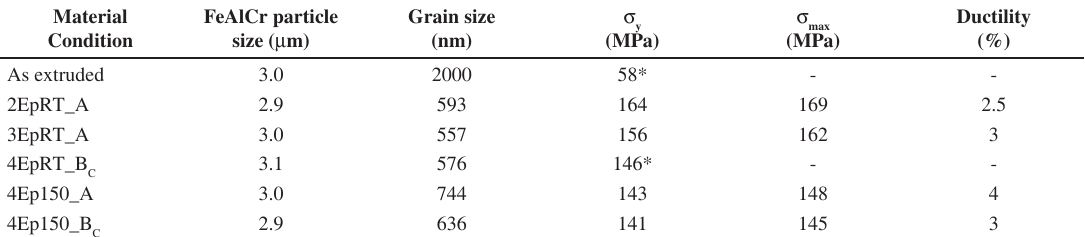
*As extruded and 4EpRT-B samples were tested in compression to determine flow stress. C